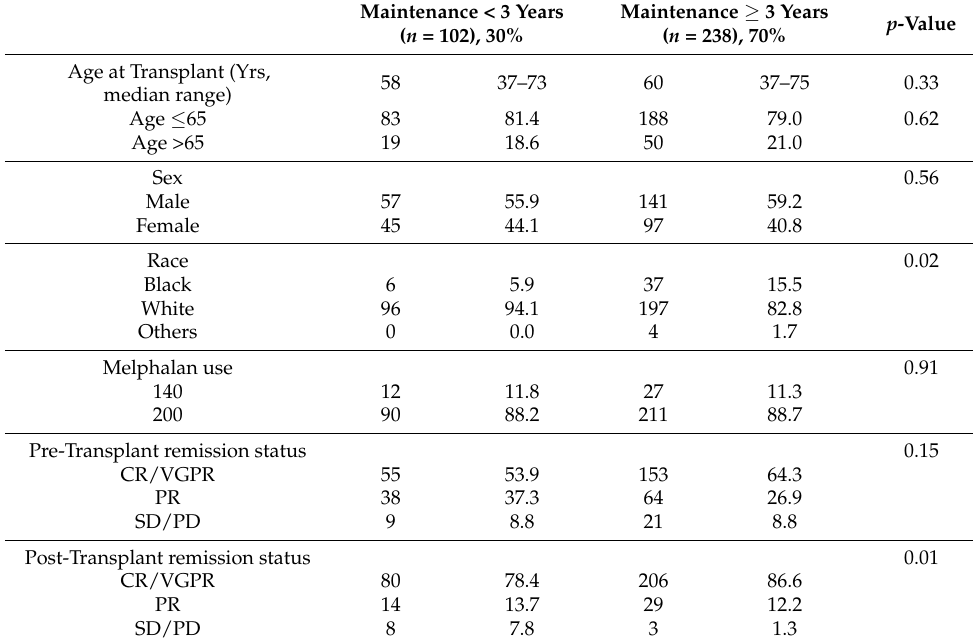
Table 1. Baseline characteristics of